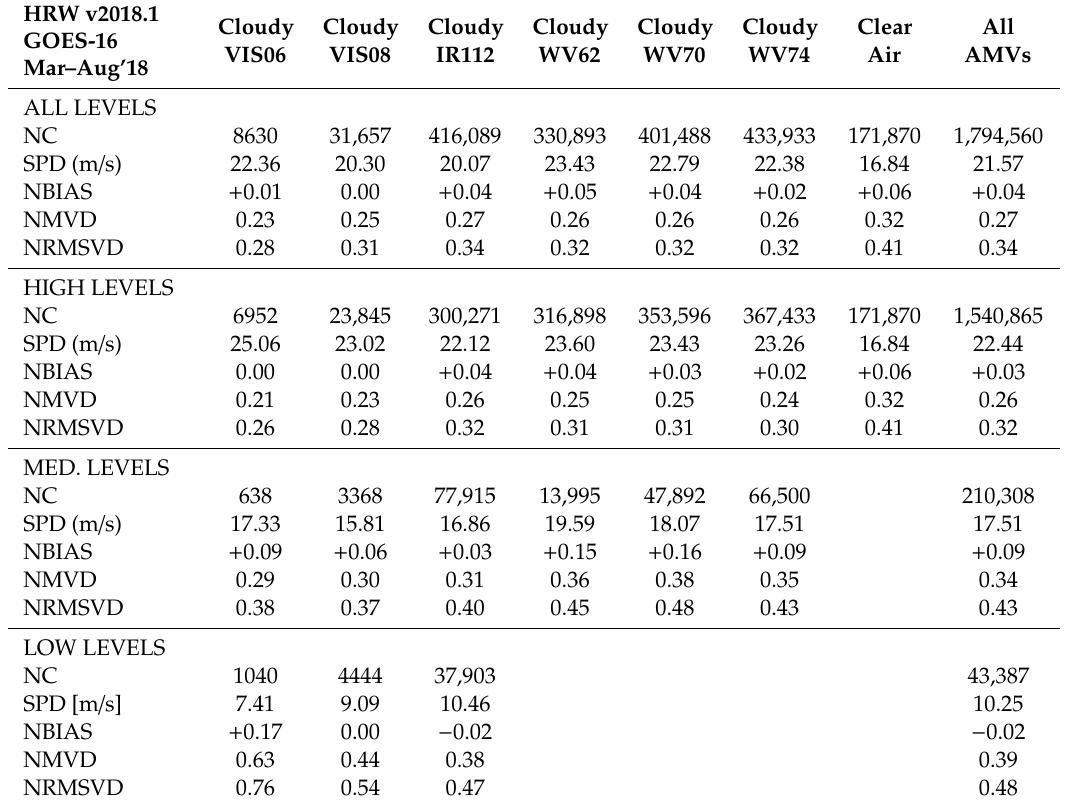
Table 7. Validation for NWC / GEO-HRW v2018.1 AMVs against radiosonde winds, considering all AMVs together and in three separate layers: high levels: 100–400 hPa; medium levels: 400–700